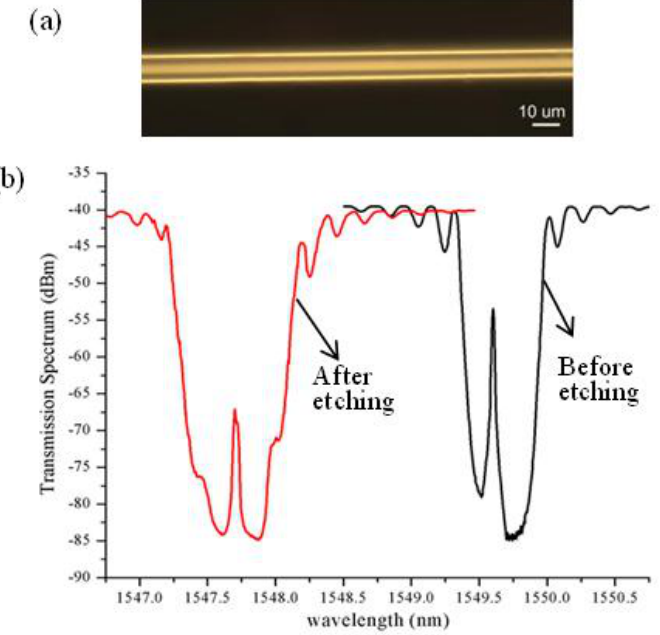
Figure 2. ( a ) Optical microscope image of an etched fiber. ( b ) Transmission spectra of a  FBG measured by an OSA before and after fiber